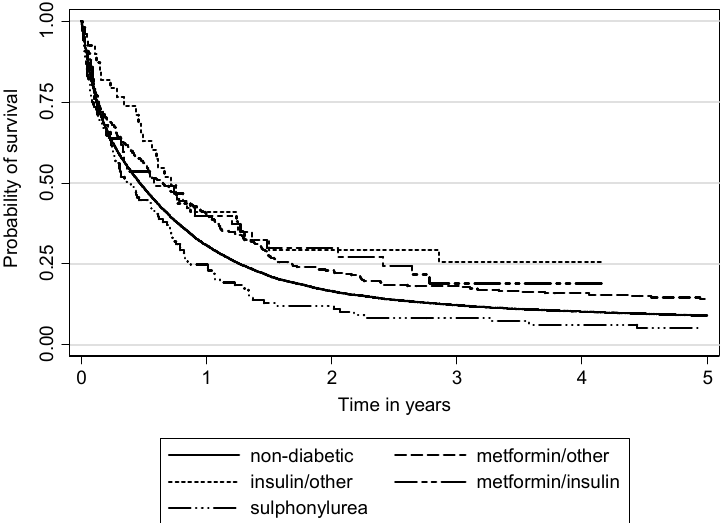
Figure 3. Overall survival between non-diabetic and diabetic patients by antihyperglycemic medication user groups ( p = 0.0004). Table 2. HR and 95% CI of the association of diabetes, antidiabetic medications use and lung cancer- specific mortality. Variable